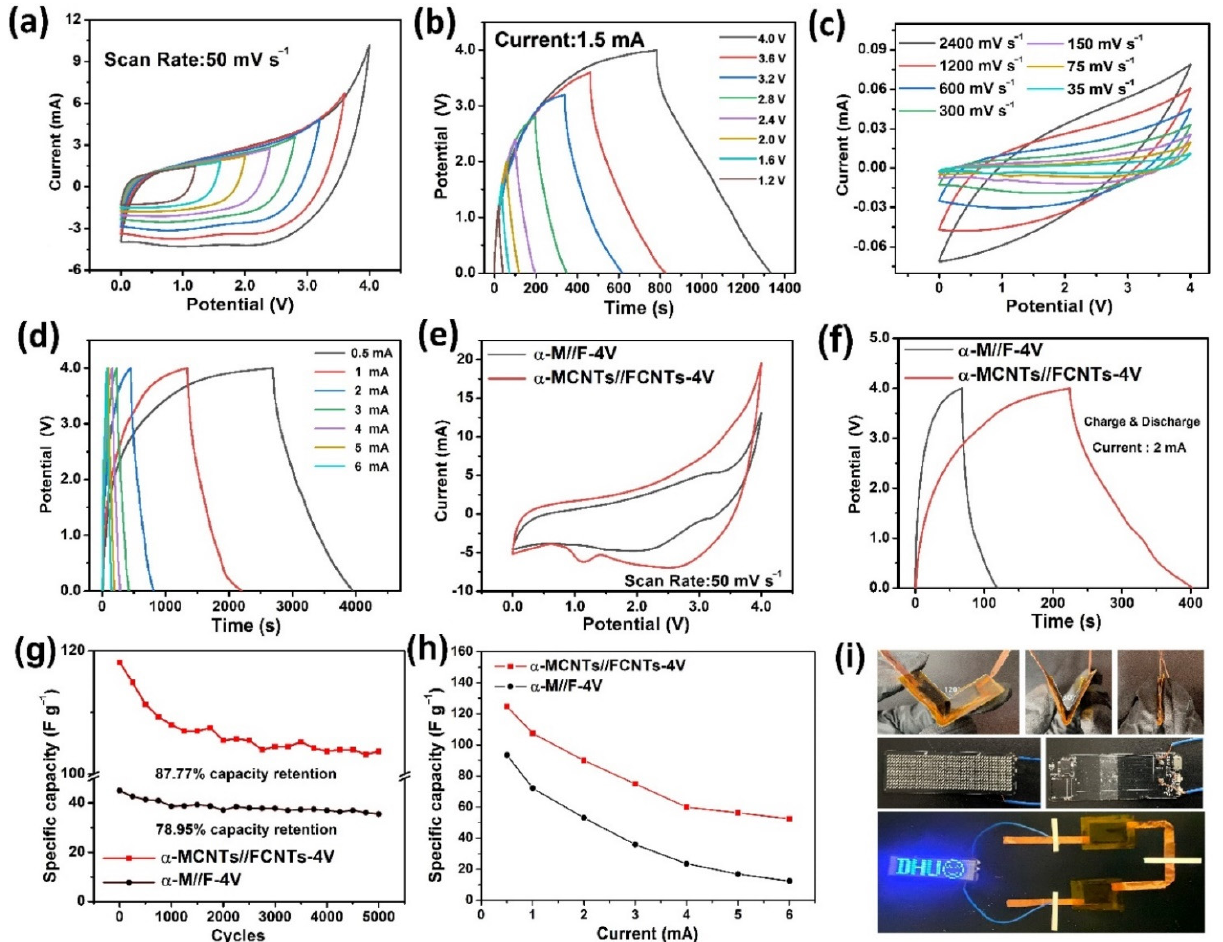
Figure 9. Electrochemical properties of the α -MCNTs//FCNTs-4V flexible supercapacitor in the EMImBF4 electrolyte: ( a ) CV plots and ( b ) GCD curves for different potential windows; ( c ) CV curves acquired at different scanning rates; ( d ) GCD plots obtained at different currents; Properties of the α -M//F-4V and α -MCNTs//FCNTs-4V flexible supercapacitor: ( e ) CV curves obtained at a scanning rate of 50 mV s − 1 , ( f ) GCD plots measured at a current of 2 mA, ( g ) 5000 cycles GCD evaluation, and ( h ) first cycle-specific capacitances measured at different currents; ( i ) Two assembled flexible ASCs in parallel powering the programmable LED arrays and with the ASCs bent at different